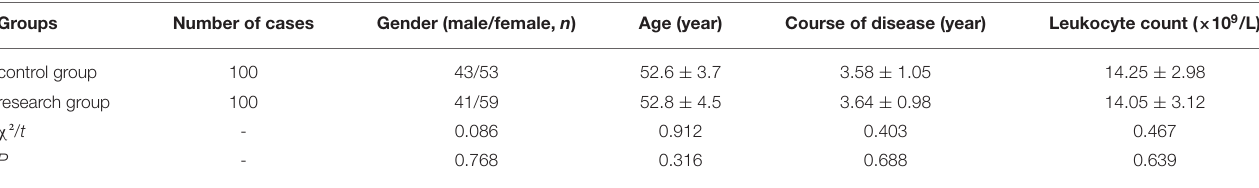
TABLE 1 | Comparison of two groups of general data.